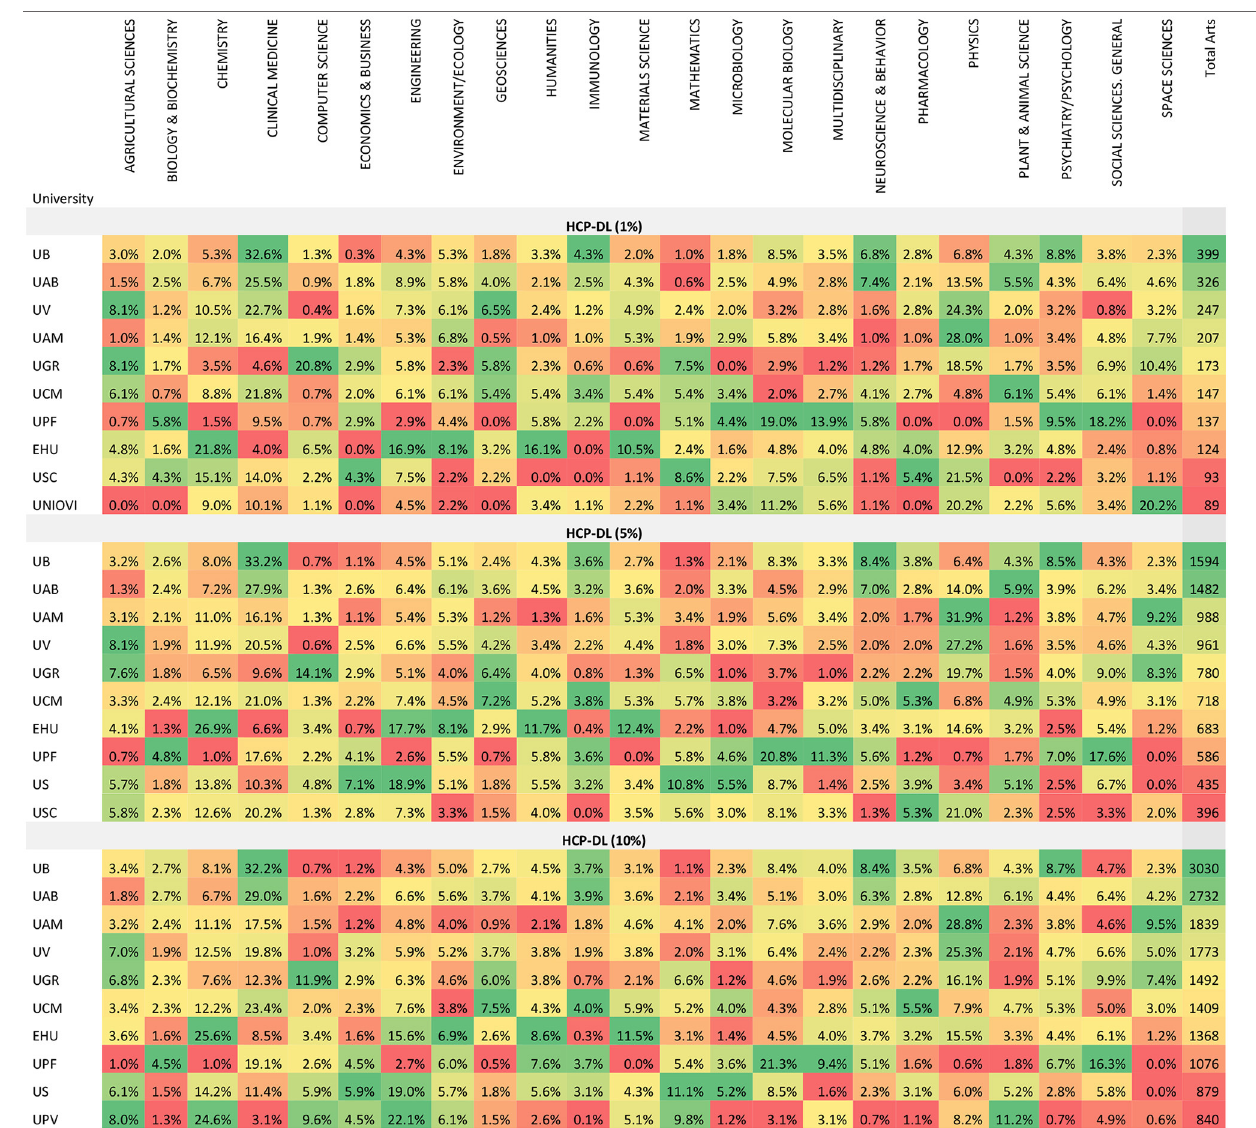
TABLE 3 | HCP-DLs by university and incites/essential science indicators area in all three top citation groups (percentages).